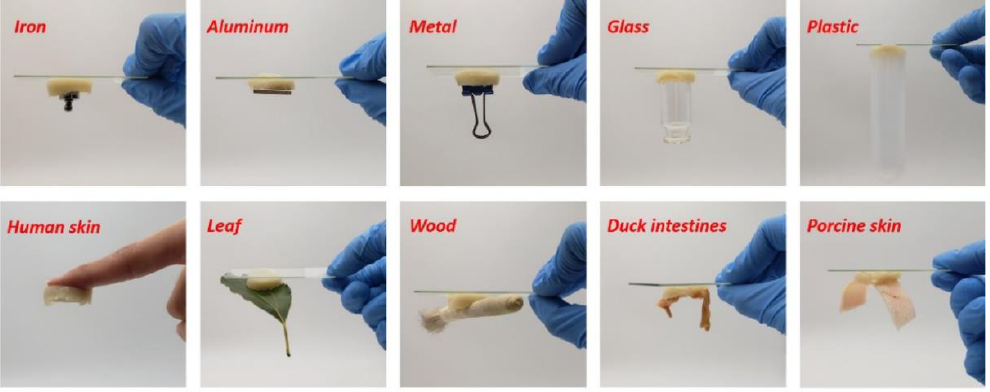
Figure 3. Adhesive property of the CaSA–GAD hydrogel to different surfaces (reprinted with permission from ref. [56]). Table 1. Summary and comparison of the outstanding properties of CPHs for strain sensing applications.